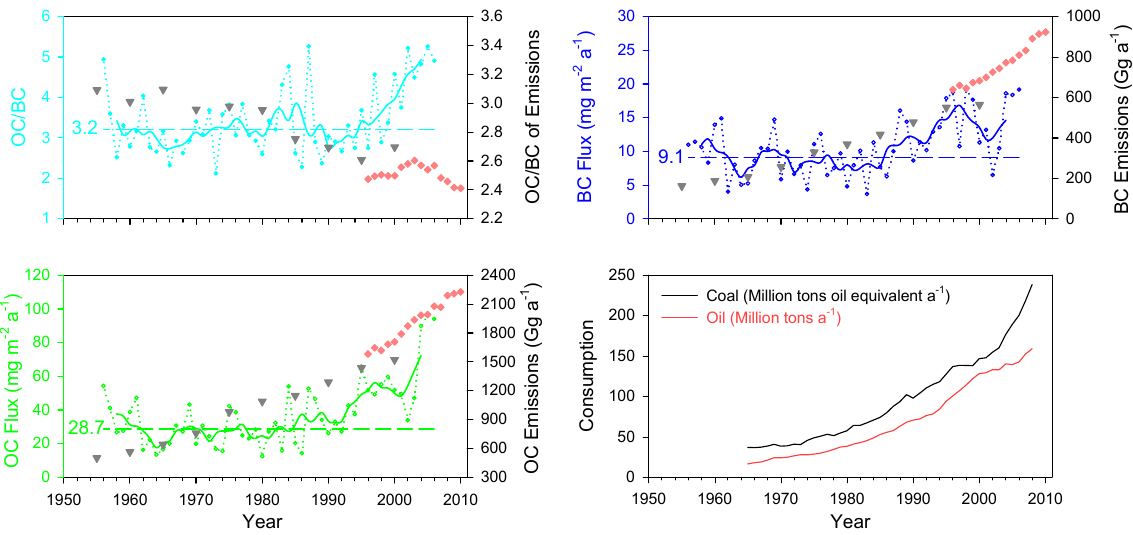
Figure 6. Time series of annual (dotted line with circles) and 5-year averaged (solid line) OC / BC ratios (top left), BC (top right) and OC deposition fluxes (bottom left) based on the Zuoqiupu ice-core measurements for the time period of 1956–2006. The average values of the OC / BC ratio, BC and OC during 1956–1979 are marked by dashed lines. BC and OC emissions in South Asia (Bond et al., 2007) and the corresponding OC / BC emission ratios are illustrated with gray triangles, and with red diamonds for emissions in India (Lu et al., 2011). Coal and oil consumption data are shown in the bottom-right panel (BP Group,